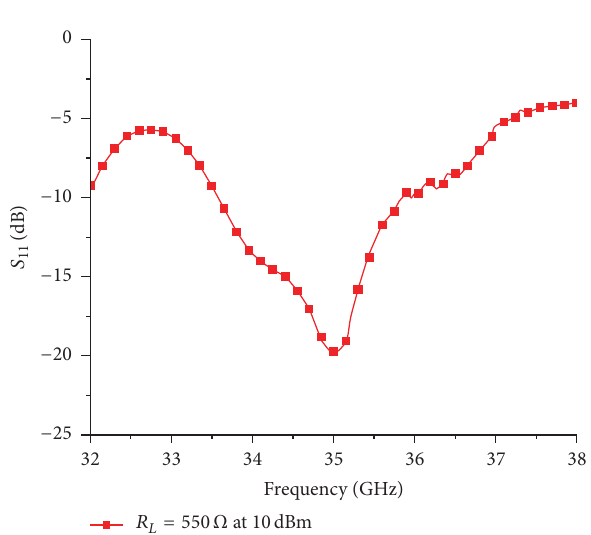
Figure 6: Measured output DC voltages and conversion efficiencies versus input power, 𝑅 𝐿 = 550 Ω , and 𝑓 = 35 GHz.